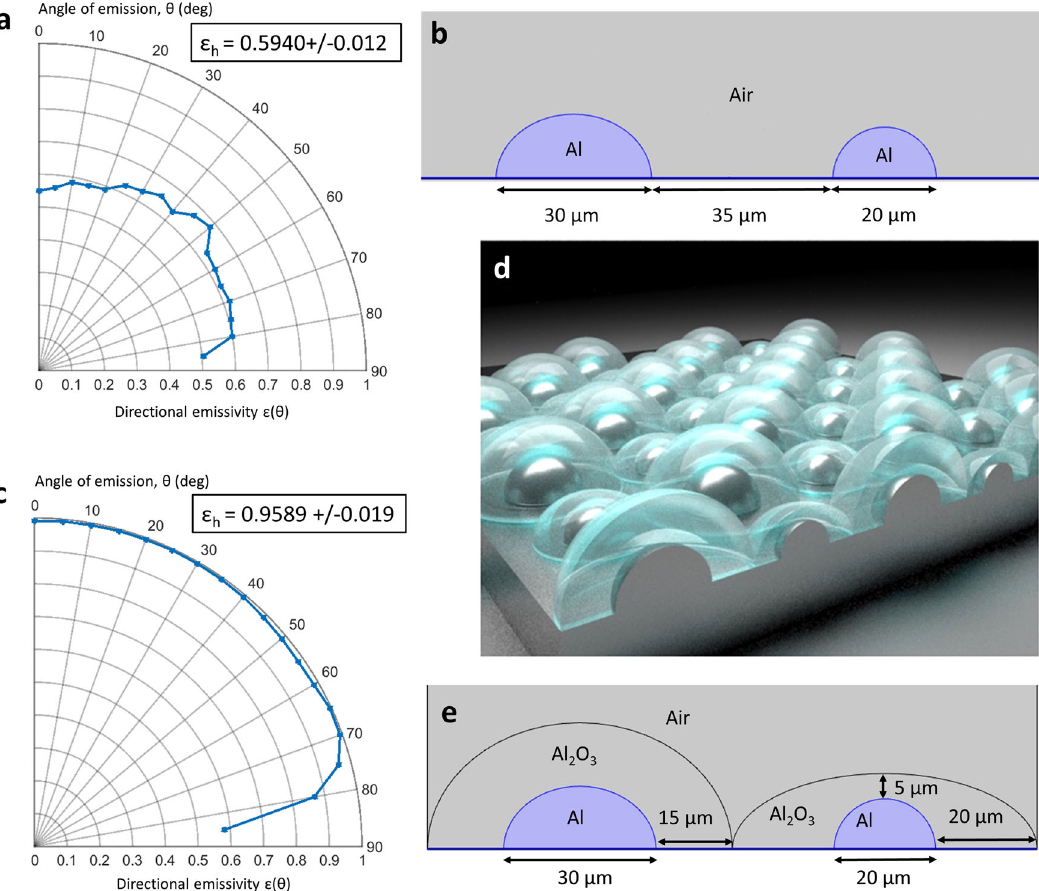
Fig. 5 Simulations of FLSP surfaces. a Simulations of directional and hemispherical emissivity for hemispherical mounds of aluminum with no oxide layer on top. c Simulations of directional and hemispherical emissivity for hemispherical mounds of aluminum with an oxide layer on top. d 3D schematic representing a periodic arrangement of the supercell used to calculate the results in c . b , e Dimensions of the supercell used in the simulations for the emissivity results shown in a and c , respectively. The presented simulations accurately agree with the obtained experimental